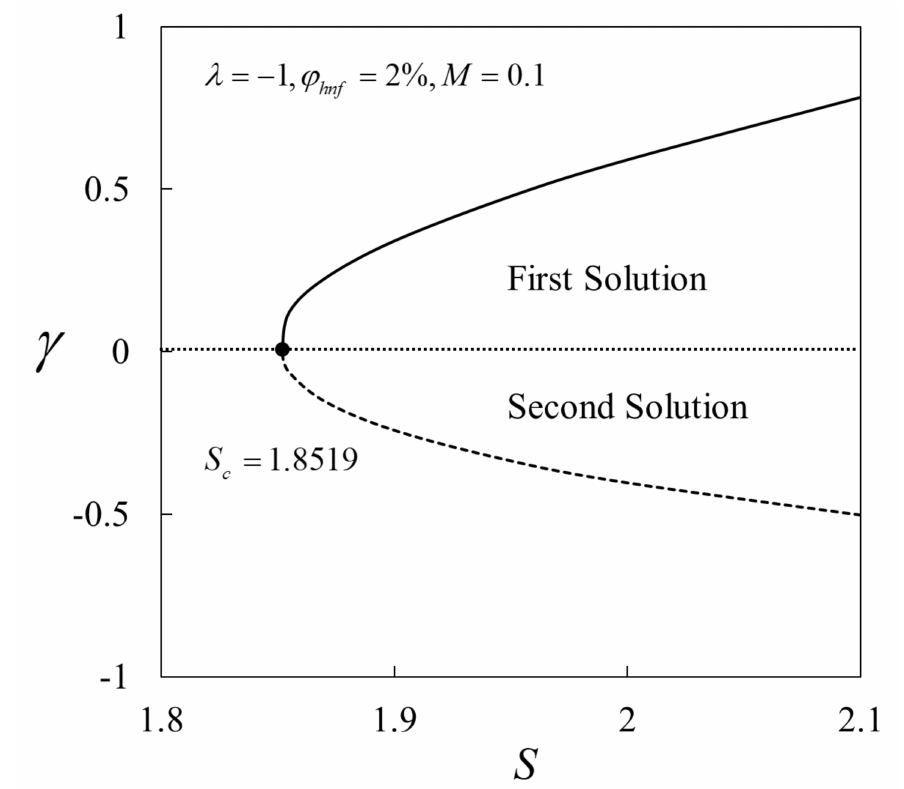
Figure 18. Variations of the minimum eigenvalues γ against suction S